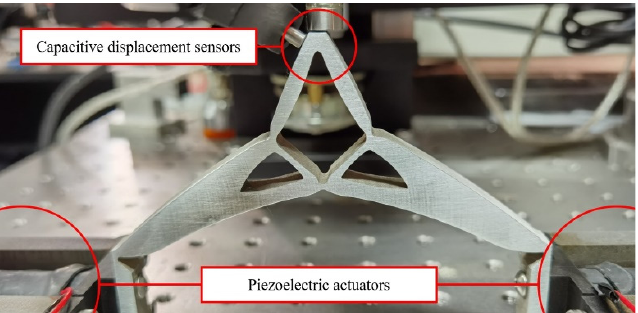
Figure 8. Image showing the experimental setup of the system. Two capacitance displacement sensors were used to measure the coupled output trajectory.